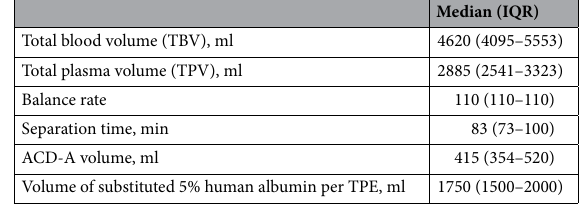
Table 2. TPE parameters. ACD-A—Anticoagulant Citrate Dextrose Solution A.